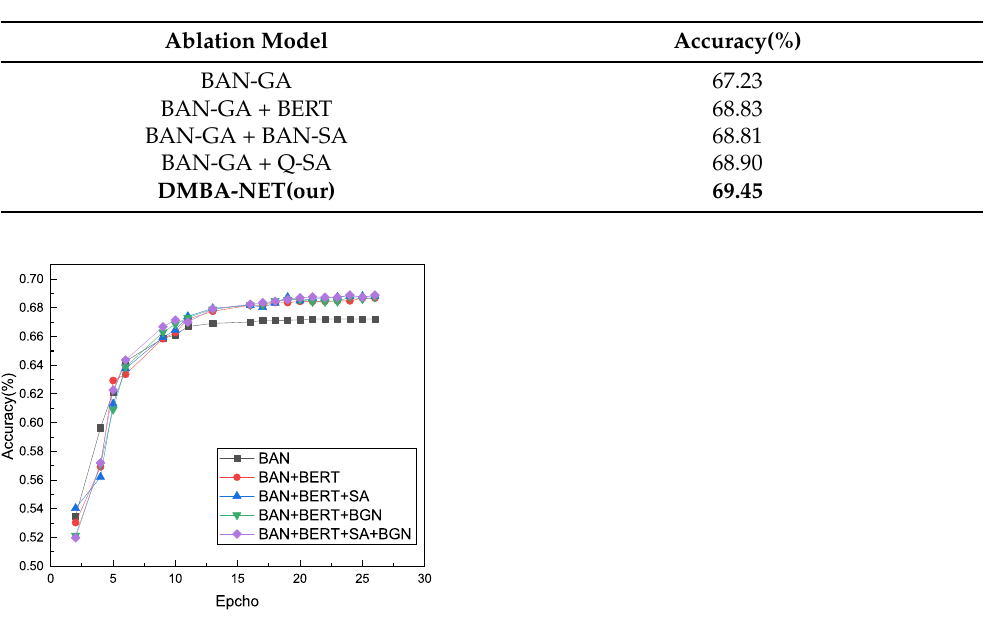
Table 2. Evaluation of ablation model on VQA v2 validation set. The highest scores are highlighted in bold font.